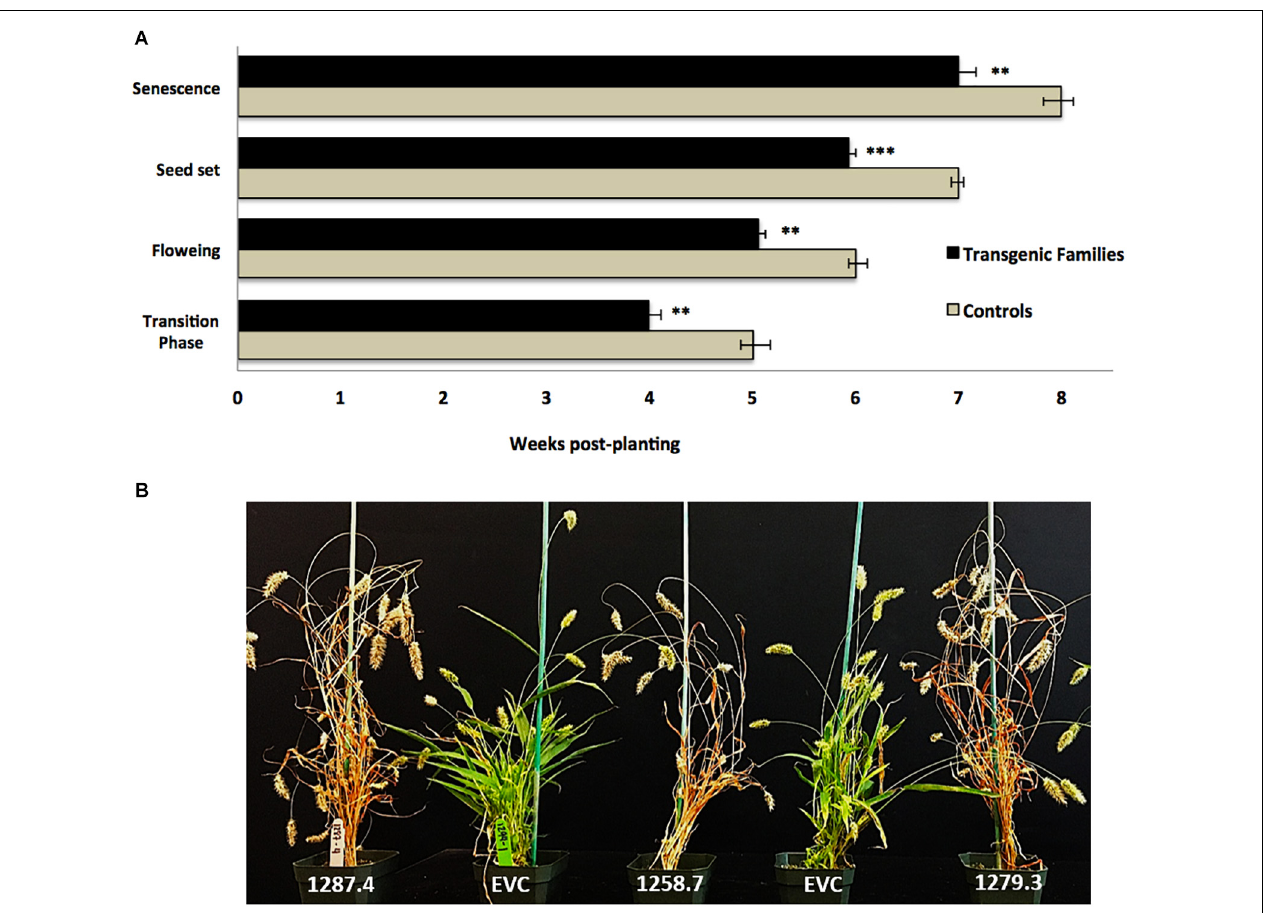
FIGURE 4 | Developmental characterization of transgenic MCOAtcel1 T 3 events (A) Accelerated developmental transitions in T 3 S. viridis families transgenic for MCOAtcel1 . Data are an average of all three transgenic families in comparison to controls. Data are shown as mean ± SEM, with p ≤ 0.001(***)/ p ≤ 0.01(**)/ p ≤ 0.05(*). (B) Early maturation of T 3 S. viridis families transgenic for MCOAtcel1 in comparison to controls 7 weeks post-transplantation. On average plants of transgenic families completed their life cycle and reached senescence 7 days ahead of the empty vector (EVC), and wild-type A10.1